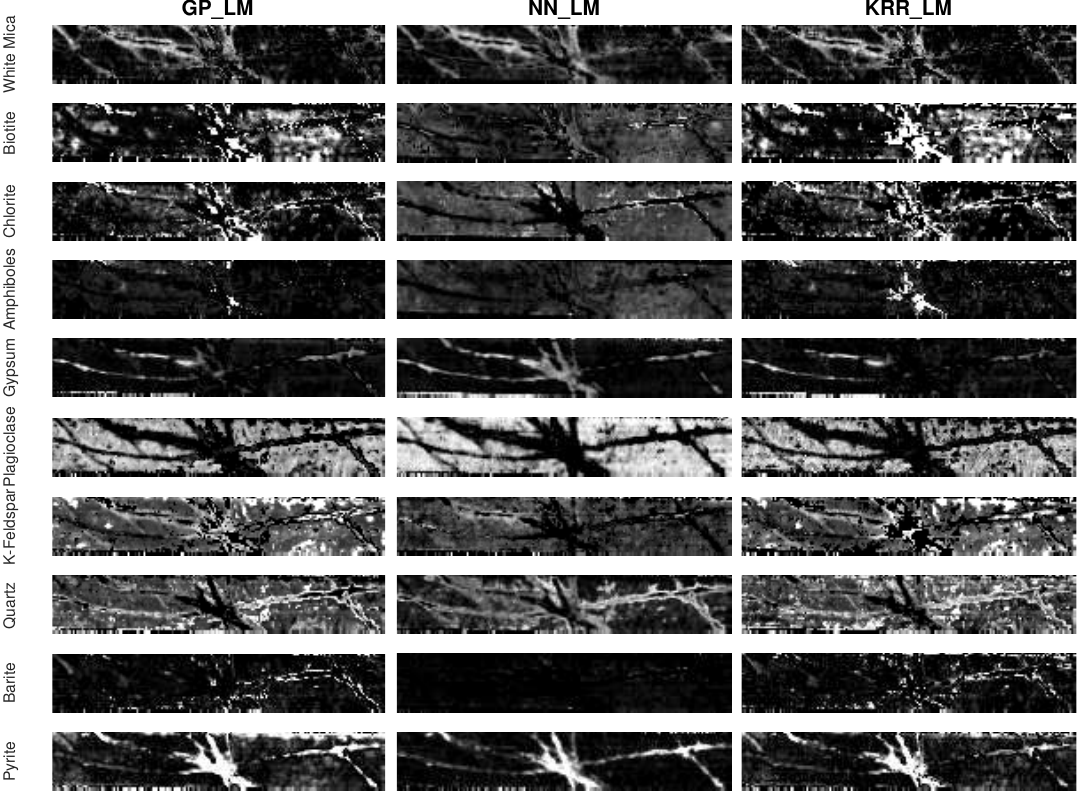
Figure 13. Estimated abundance maps of entire drill core sample (applying a map learned by using 373 training pixels). All images are normalized by the largest abundance value in the GT